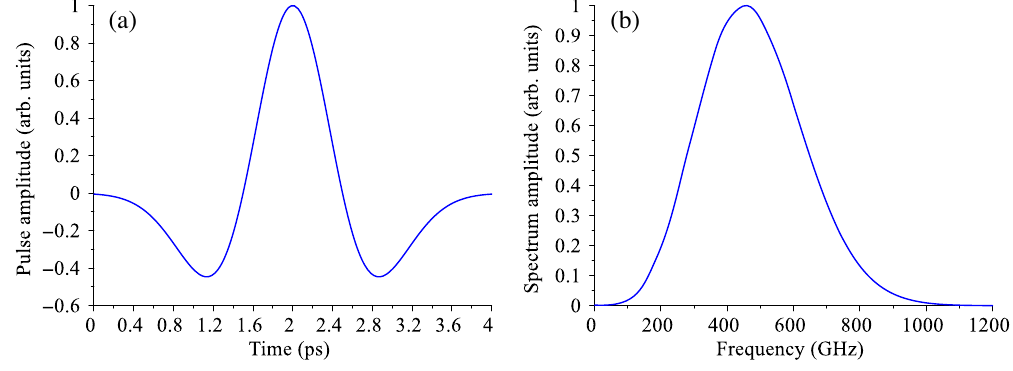
FIG. 1. Single-cycle THz pulse shape (a) and spectrum (b).